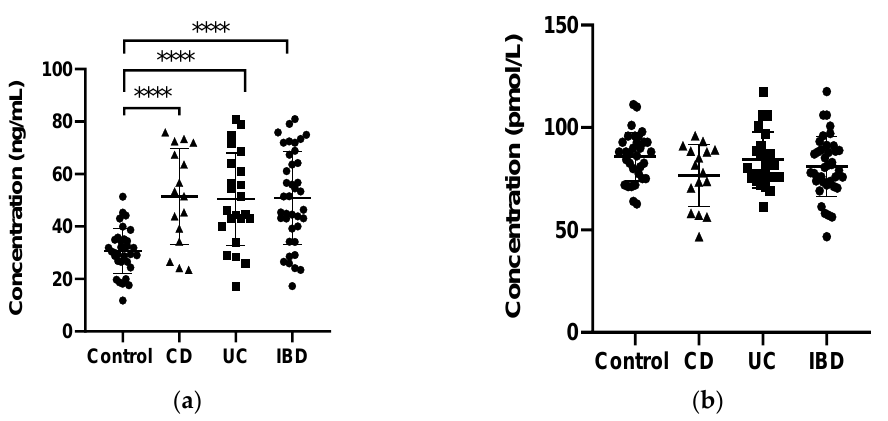
Figure 1. Serum concentrations of 25-hydroxy Vitamin D (25(OH) Vitamin D) ( a ) and 1,25-hydroxy Vitamin D (1,25(OH)2 Vitamin D) ( b ) in healthy subjects (control), in patients with Crohn's disease (CD) and ulcerative colitis (UC) and the whole test IBD patient group. **** p < 0.0001, the difference between CD and UC was not statistically significant.